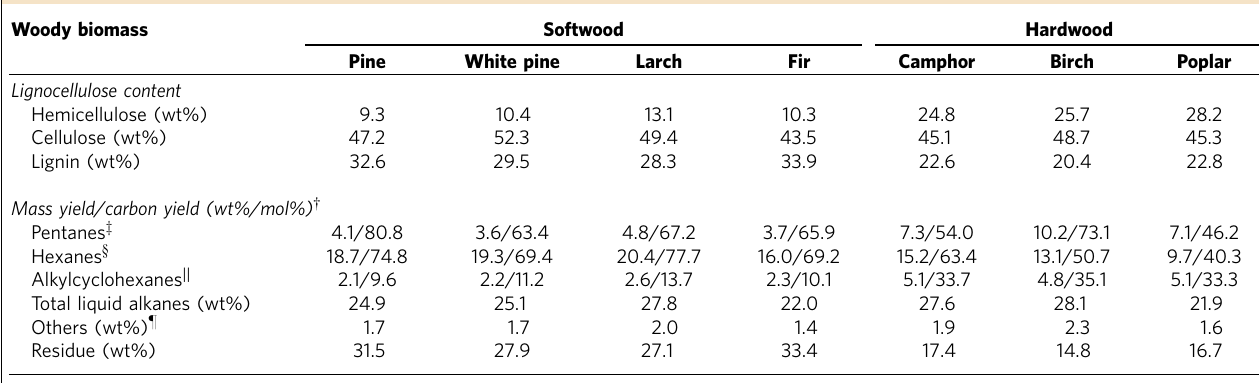
Mass yield/carbon yield (wt%/mol%) w Pentanes z